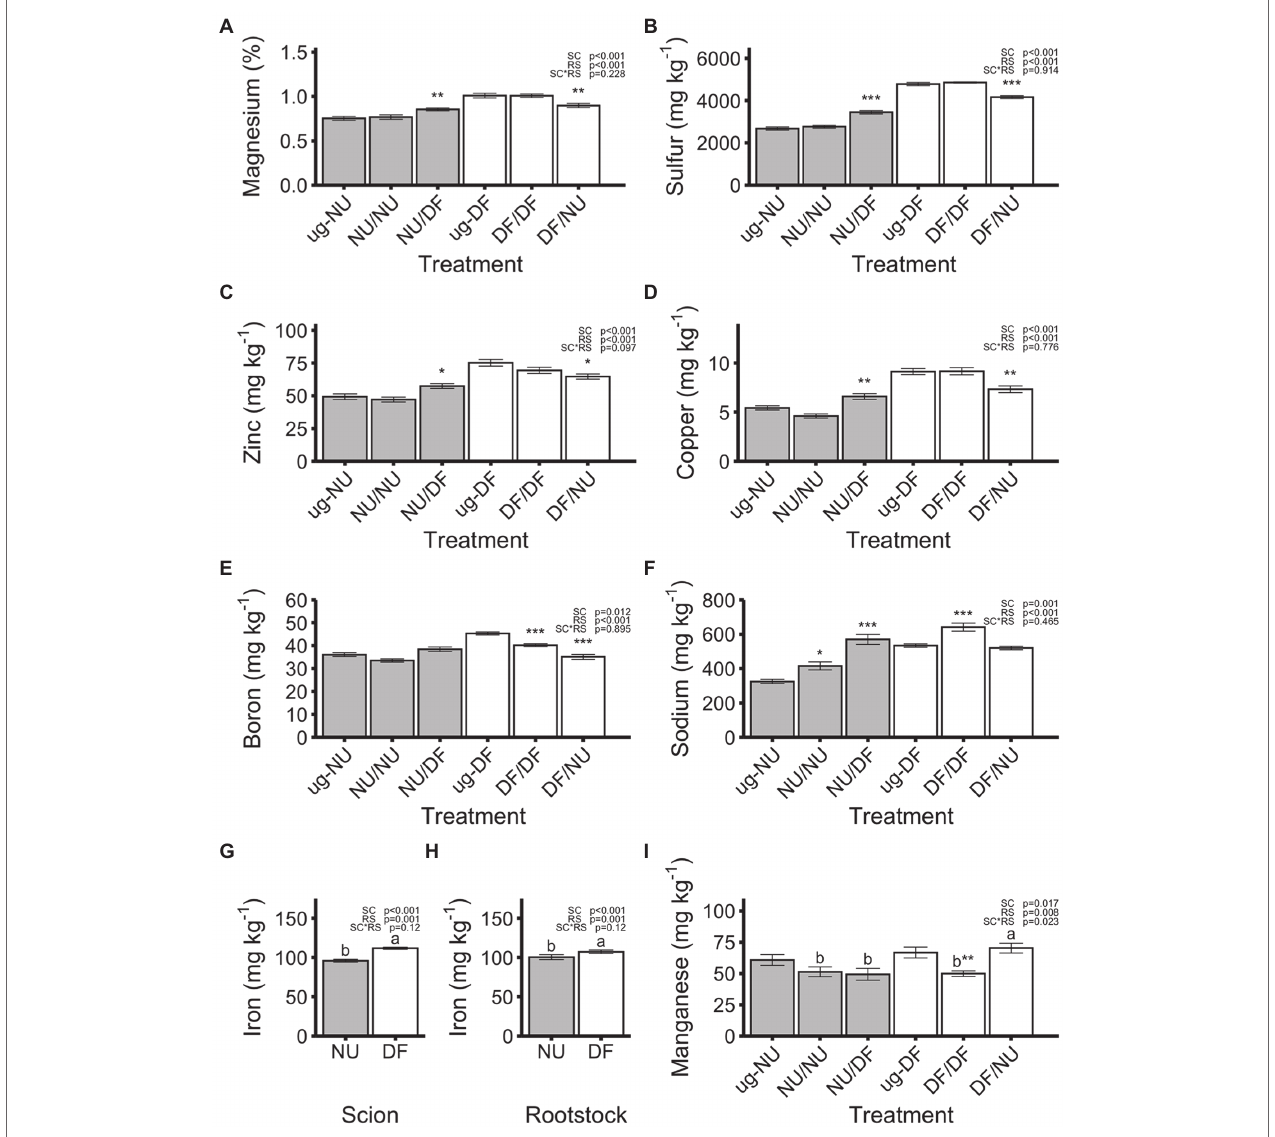
FIGURE 4 | Concentrations of magnesium (A) , sulfur (B) , zinc (C) , copper (D) , boron (E) , sodium (F) , iron (G,H) and manganese (H) in dry shoot tissue in the second trial. Values are means of 6 replicates for each treatment (A–F,I) or 24 replicates for each scion or rootstock cultivar (G,H) and error bars represent standard error. Asterisks above bars indicate significant difference between grafted treatment and the un-grafted control of the same scion cultivar by Dunnett’s test [***( p ≤ 0.001), **( p ≤ 0.01), and *( p ≤ 0.05)]. p -values indicate significance of scion (SC), rootstock (RS) and scion by rootstock interaction (SCxRS) effects from the factorial analysis of self- and inter-cultivar grafted plants (four treatments excluding un-grafted controls). Letters indicate mean separations for the four